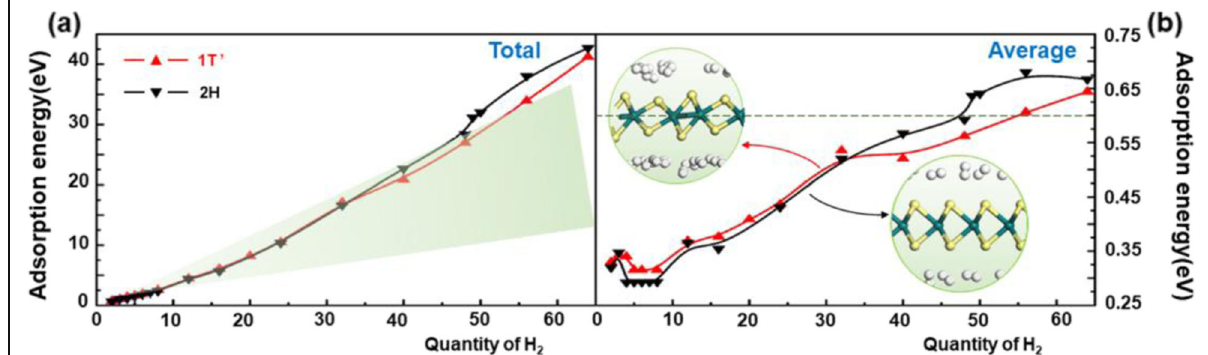
Fig. 3 Graphs of a total adsorption energy and b average adsorption energy as a function of the number of hydrogen molecules absorbed on the 1T ’ - and 2H-WS 2